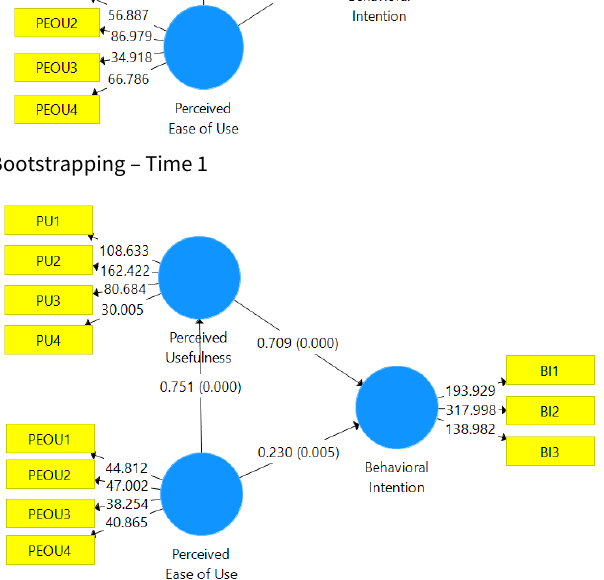
Figure 6. Results after running Bootstrapping – Time